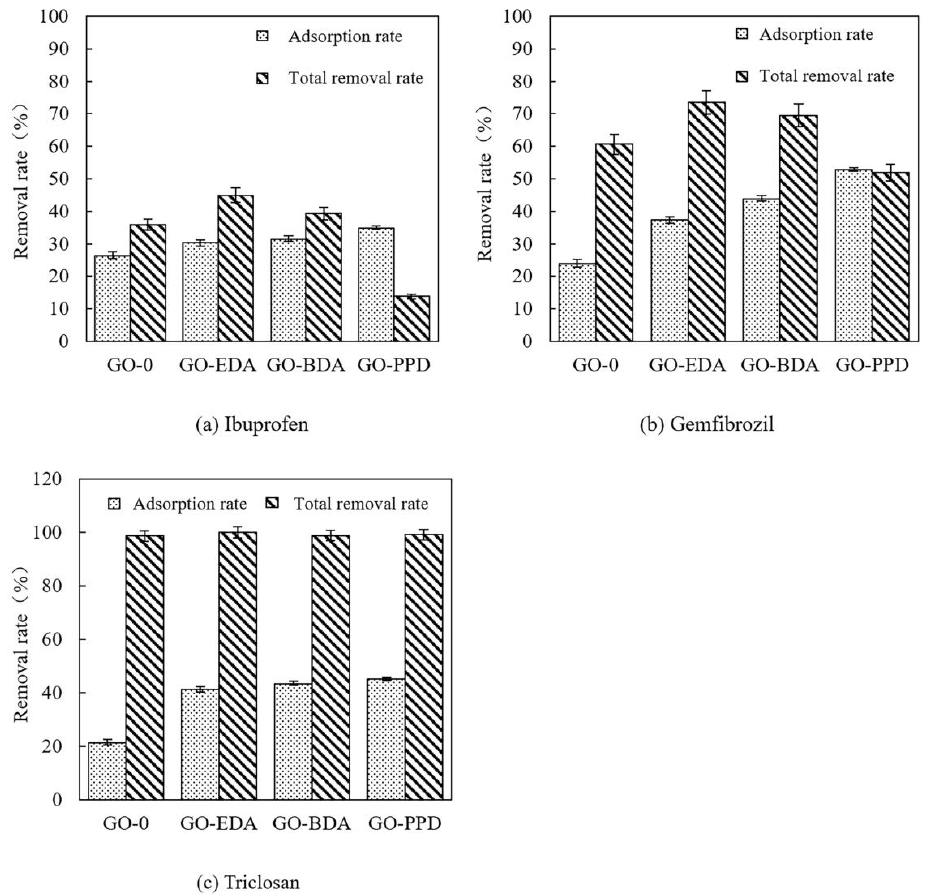
Figure 8. The adsorption rate and total removal rate of PPCPs: ( a ) ibuprofen, ( b ) gemfibrozil, ( c ) triclosan using the cross-linked GO membrane at pH 3.